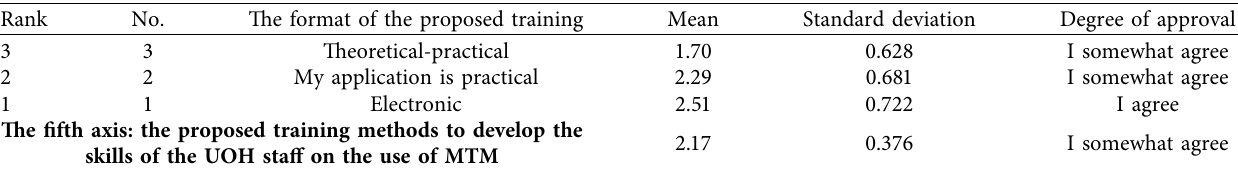
Table 9: The averages and standard deviations of the questionnaire, in the fifth axis: the proposed training methods to develop the skills of staff at the UOH in the use of MTM.